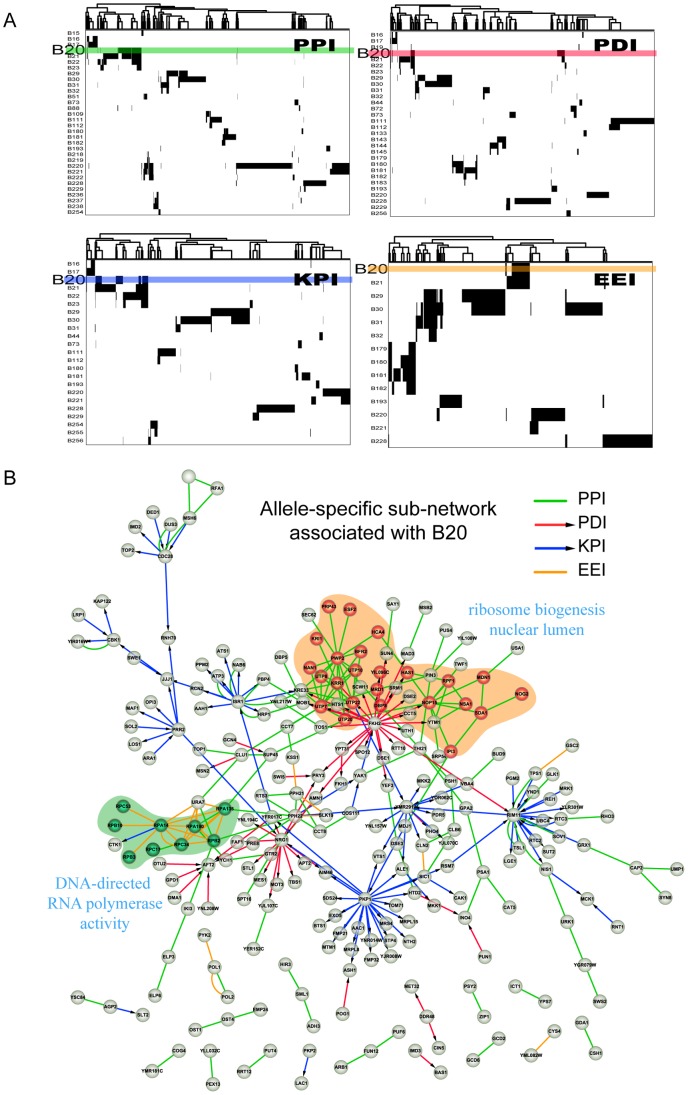
The changing pattern of molecular networks under allele-specific context determined by LD blocks.(A) Hierarchical clustering on the perturbed interactions based on the association matrix between blocks and their perturbing interactions in PPI, PDI, KPI, and EEI networks, respectively, in which rows represent blocks and columns represent interactions. In each of the four sub-matrices, blocks associated with less than ten interactions are filtered out. The columns are reordered according to hierarchical clustering. The rows colored correspond to B20. (B) The allele-specific sub-network associated with B20. The sub-network is composed of 142 PPIs, 54 PDIs, 93 KPIs, and 26 EEIs, which are marked with green, red, blue and orange, respectively. Nodes marked with red are proteins constituting a GO cellular component (nuclear lumen), and PPIs among these genes are regulated by B20. Nodes marked with green are enzymes from a KEGG pathway (DNA-directed RNA polymerase activity), and their EEIs are regulated by B20.